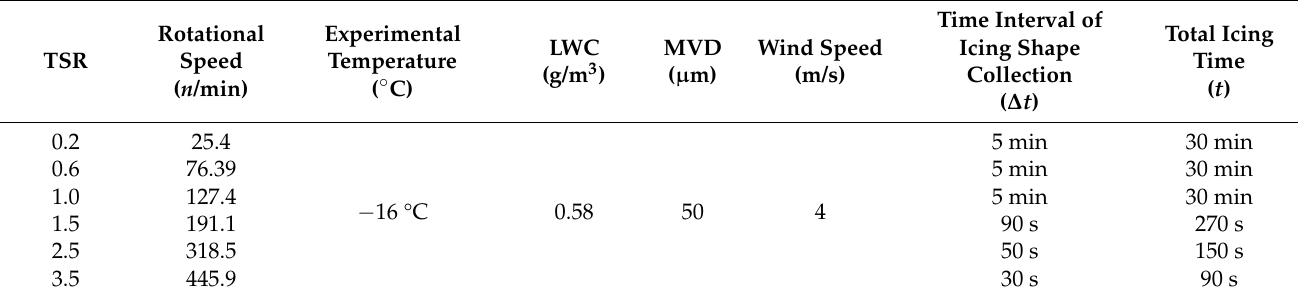
Table 1. Experimental scheme and